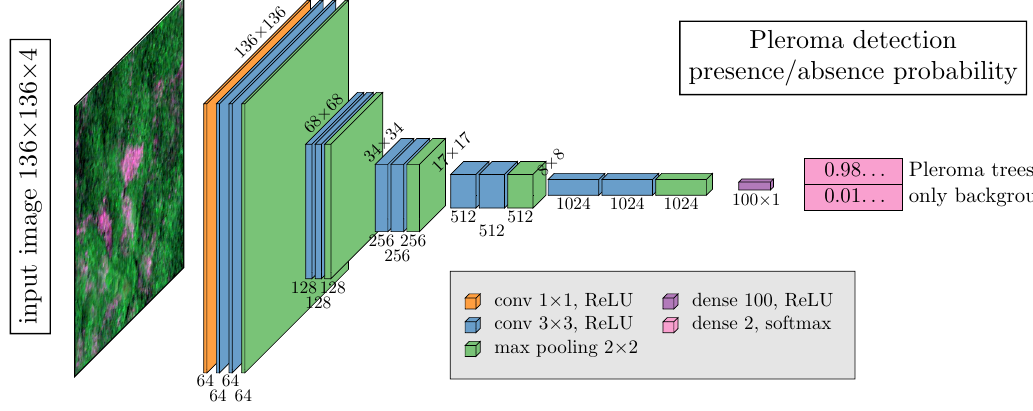
Figure 13. Architecture of the Pleroma blossom detection pixel images. In our case here, the deep learning analysis was made with 128 × 128 pixel images and an additional 8 × 8 border. Sentinel L1C reflectance values are in the range of 0–10000 and were converted to 8 bits (0–254) with the following rules : for Red, Green and Blue bands, we kept the minimum value between 2540 and the original pixel value, divided this value by 10 and converted the result to integer; and for the NIR band, we keep the minimum value between 2540 and the original pixel value divided by a constant equaling 3.937, divided this value by 10 and converted the result to integer. While it was not expected to have RGB pixel values for vegetation with reflectance above 2540, it occured frequently for the NIR values. Dividing the NIR band values by the con- stant 3.937 enabled scaling the full range of the original NIR values between 0 and 2540 without losing too much